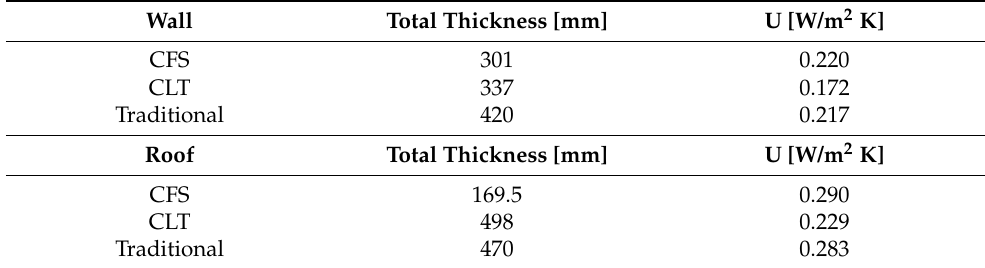
Figure 8. Wall configurations: ( a ) CFS; ( b ) CLT; ( c ) traditional. Table 2. Total thickness and thermal transmittance